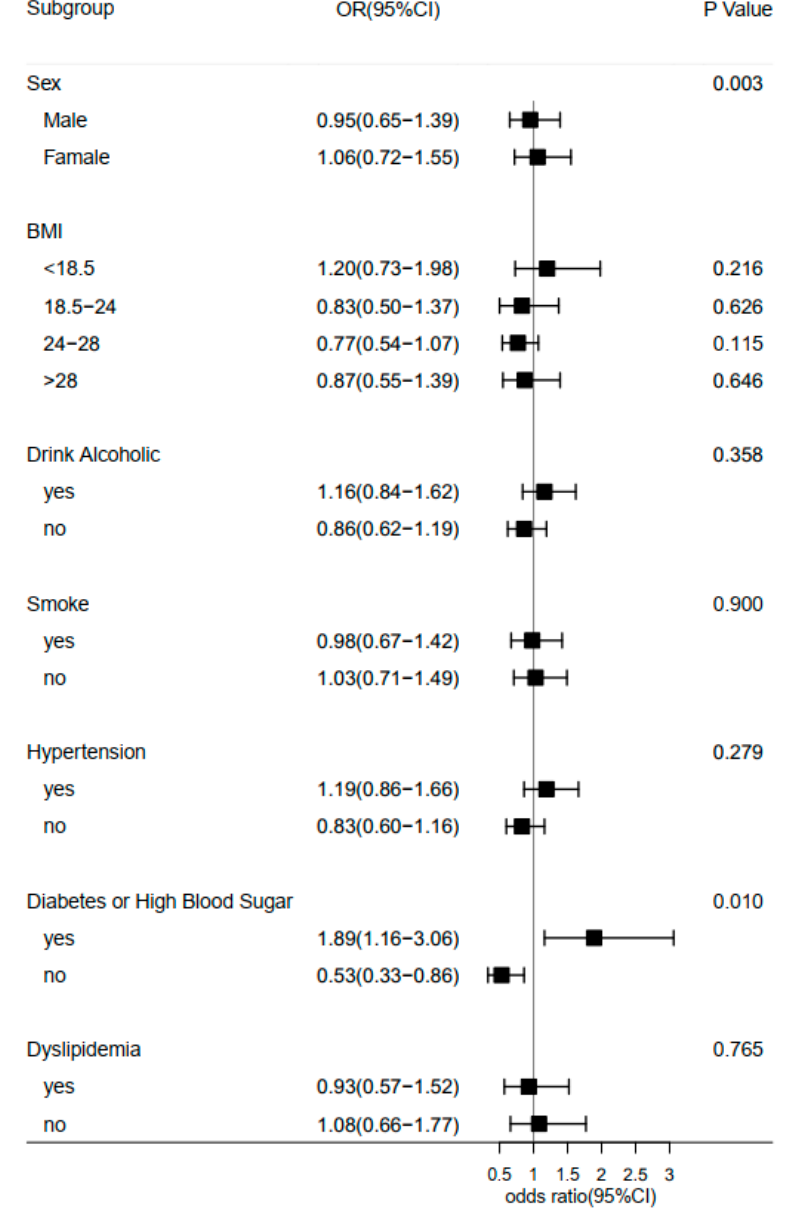
Figure 5. Joint effects of sleep duration and midday napping on hip fracture.